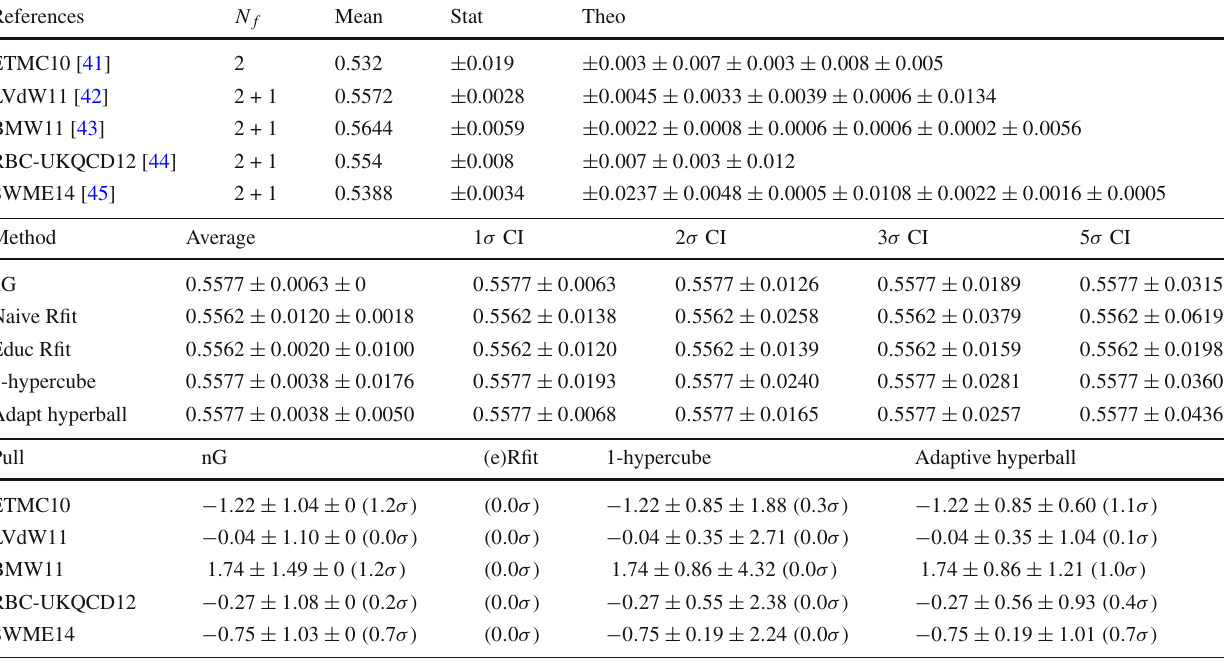
Table 6 Top: lattice determinations of the kaon bag parameter ¯ MS ( 2GeV ) . Middle: averages according to the various methods, and B K corresponding confidence intervals for various significances. Bottom: pulls associated to each measurement for each method. For Rfit meth-